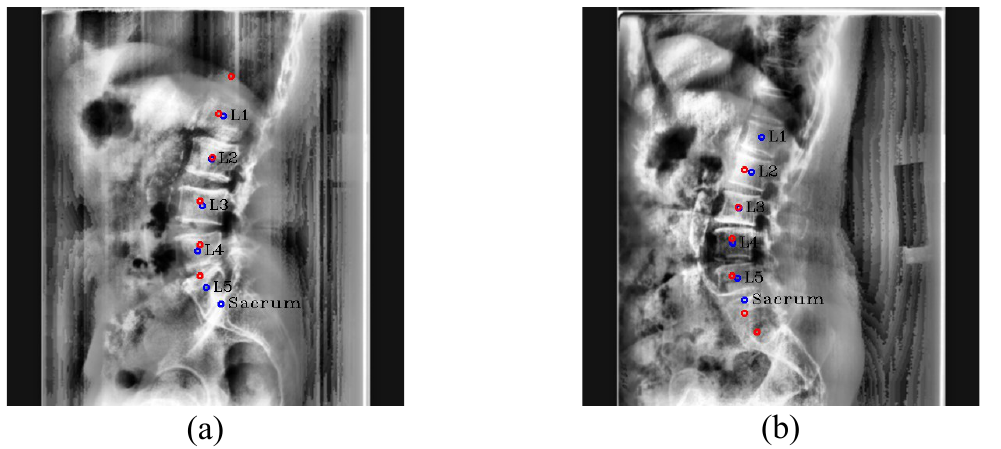
Figure 11. Center detection failure cases. ( a , b ) are outlier cases caused by the similar appearance of L5 and the sacrum. The red circles denote the predicated centers of L1, L2, L3, L4, L5, and the sacrum in order from the top, and blue circles and labels denote the ground truth of the